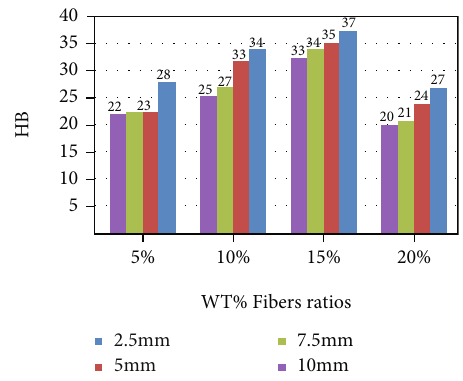
Figure 5: Average hardness values for RP-DPF composites for di ff erent lengths and weight ratios of DPF.